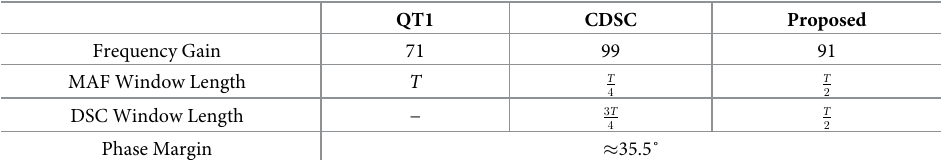
Table 1. Parameter values of the selected PLL